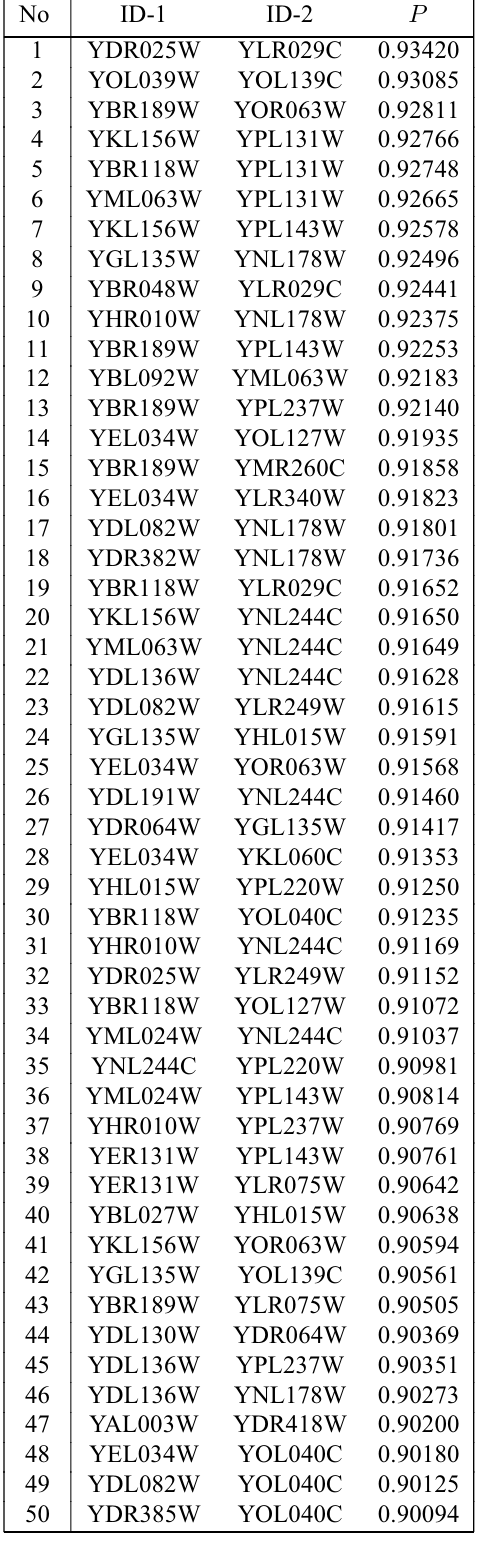
Table 1: List of 50 highly ranked new potential PPI targets predicted by the Parzen OCC